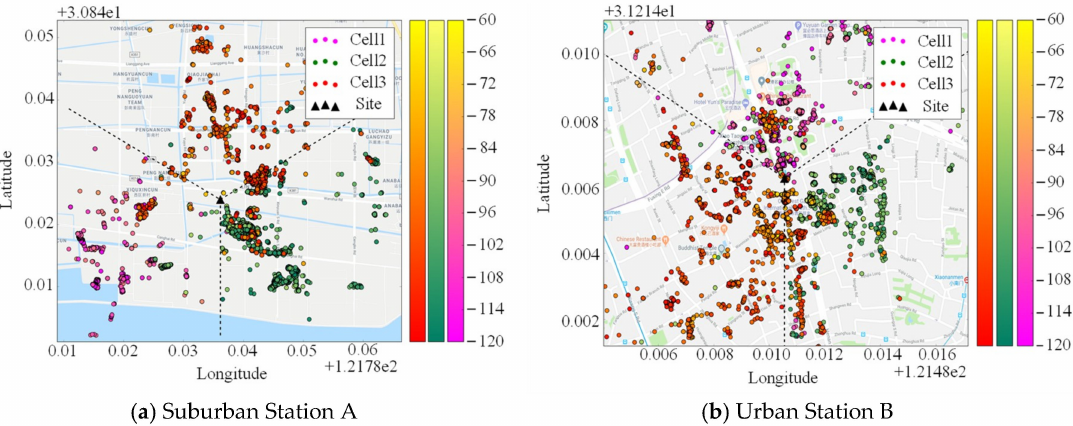
Figure 8. Spatial distribution of the BS and samples (dotted line is the border of co-site sectors, the angle bisector of each sector is the direction of antenna azimuth). ( a ) Suburban Station A; ( b ) Urban Station B.